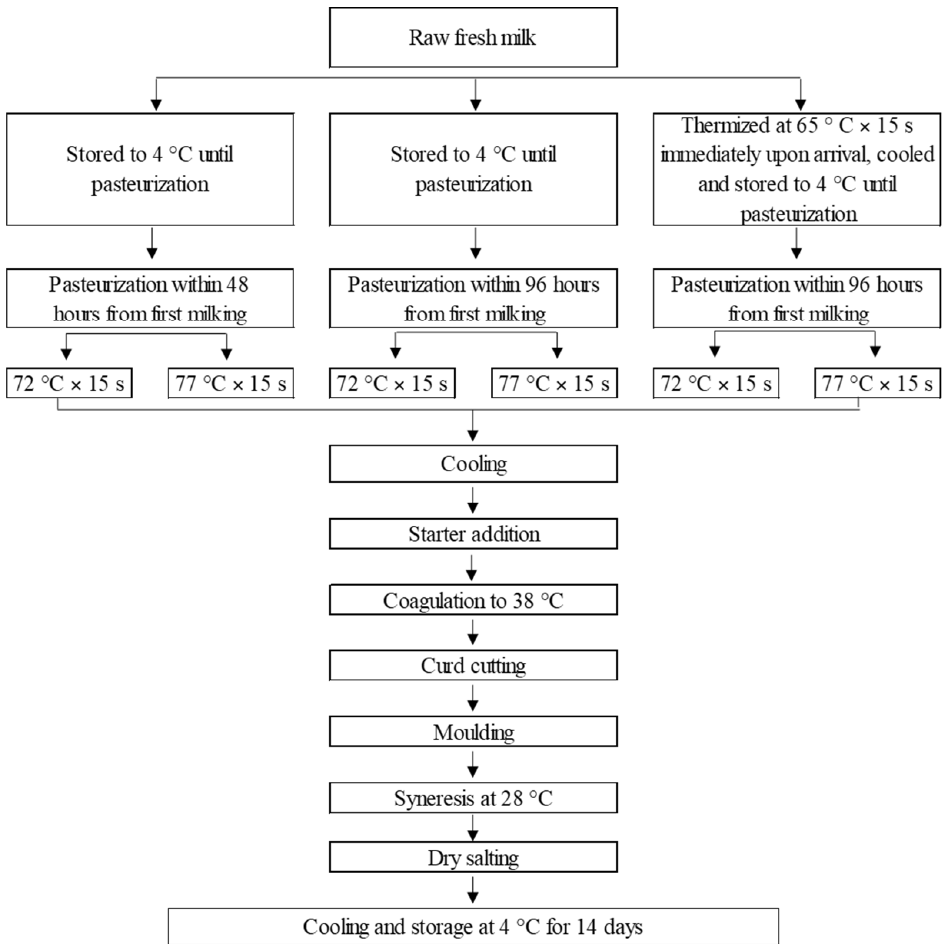
Figure 1. Flow chart of production of cheese samples.